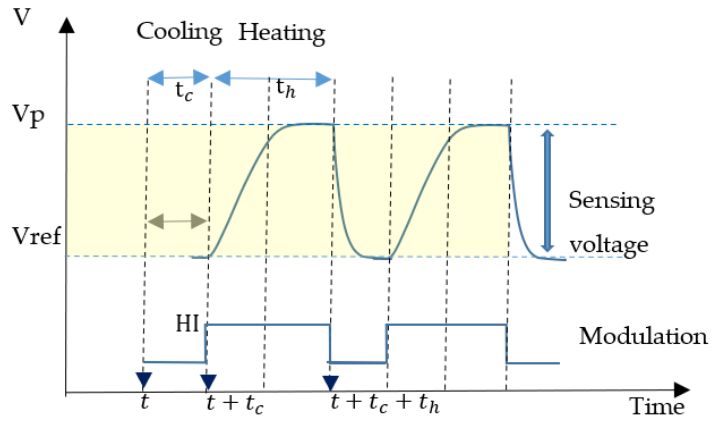
Figure 2. Output voltage and the periodic modulation of IR light source.